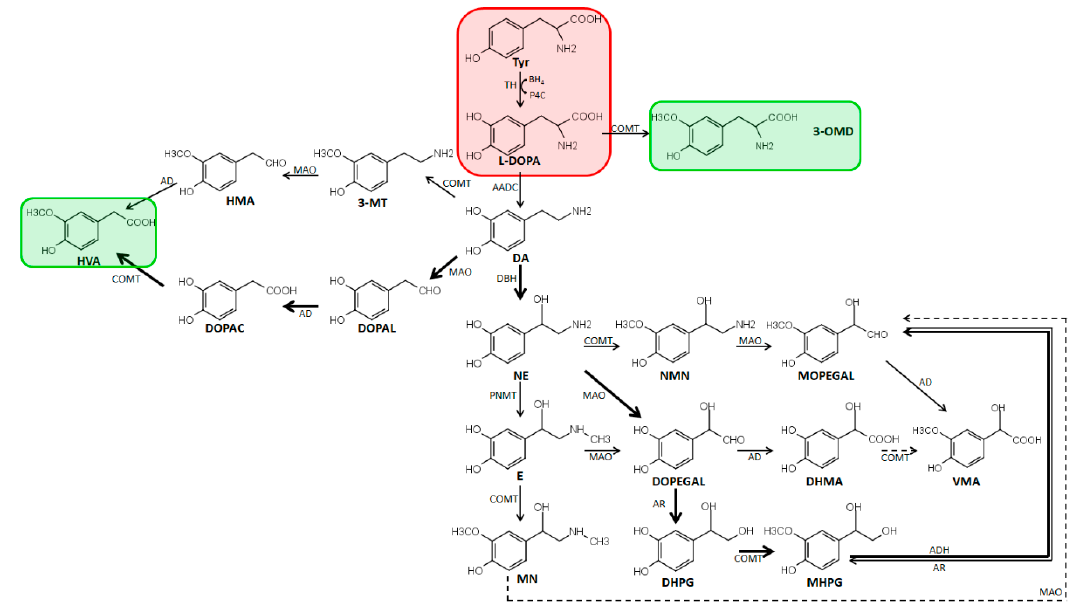
Figure 1. Catecholamine biosynthesis and metabolism. AADC, aromatic amino acid